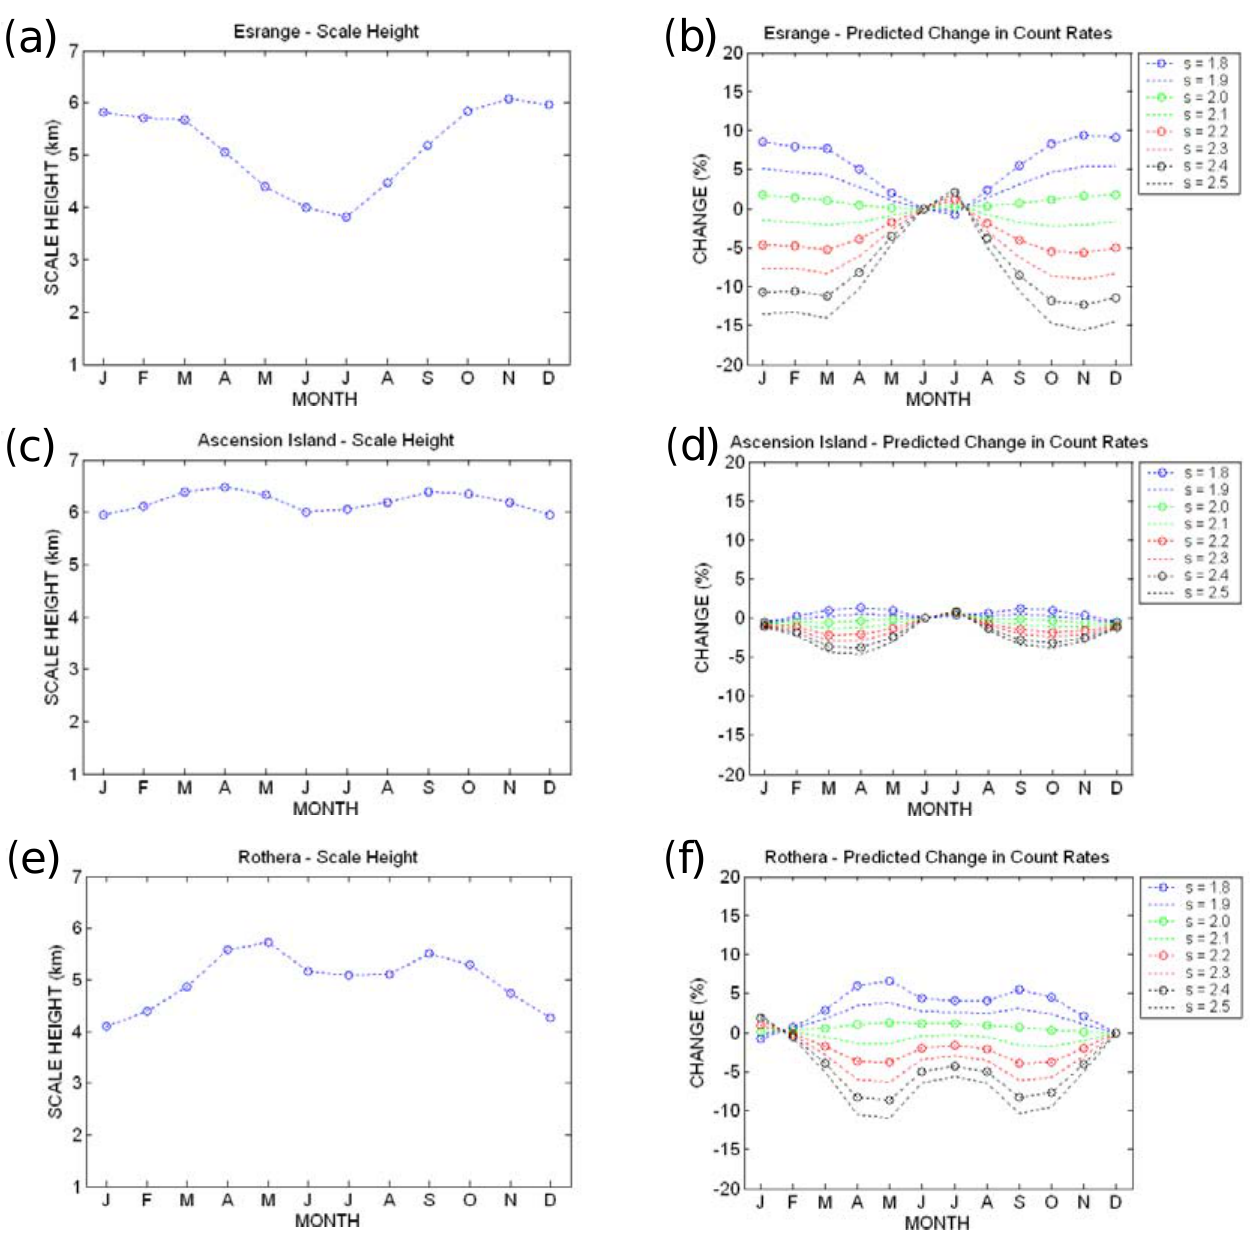
Fig. 6. (a) The monthly-mean atmospheric scale height over Esrange (at 90km) from temperature and density values taken from the MSIS- 90 model, (b) Percentage change in meteor count rate as a function of time and meteor mass index s . Change is expressed as percentage deviation away from maximum values, (c) As Fig. 5a but for Ascension Island. (d) As Fig. 5b but for Ascension Island, (e) As Fig. 5a but for Rothera and (f) As Fig. 5b but for